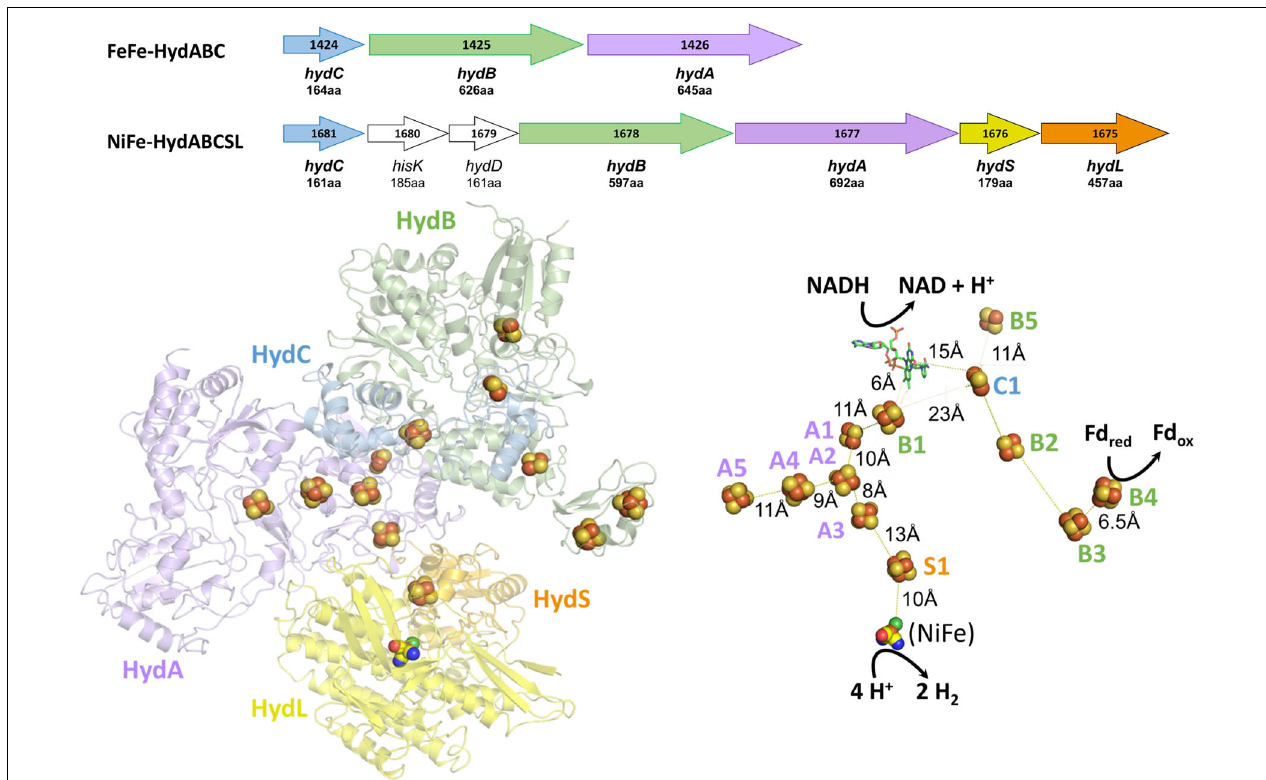
FIGURE 1 | Operons, structures, and cofactor content of the A. mobile bifurcating NiFe-hydrogenase. Upper : the operons encoding Thermotoga maritima FeFe-HydABC and A. mobile NiFe-HydABCSL are shown where colors indicate homologous subunits. Numbers inside the arrow refer to the gene number and the numbers of amino acids encoded are indicated. The proteins encoded by hydS and hydL are homologs of non-bifurcating NiFe-hydrogenases but hisK and hydD are not part of the NiFe-holoenzyme. Lower : the cryoEM protein structure of pentameric NiFe-hydrogenase from A. mobile showing the cofactor content of the ABCSL subunits (adapted from Feng et al., 2022). The iron sulfur clusters are numbered according to the subunit that contains them. The distances between the C1, B2, and B3 clusters are not shown since, in contrast to the other distances shown, they vary during the electron bifurcation reaction. As discussed in the text, elsewhere in the manuscript the Hyd designation is replaced by